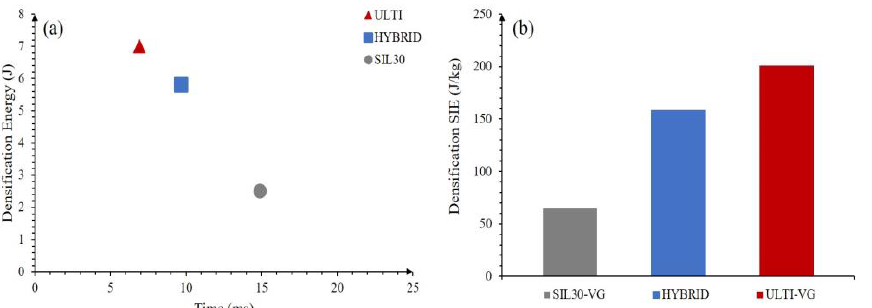
Figure 9. Impact energy response at the densification point for the double stacked vertically-graded systems; ( a ) densification energy, ( b ) densification specific impact energy. The compromise resulting from combining materials is evident here.